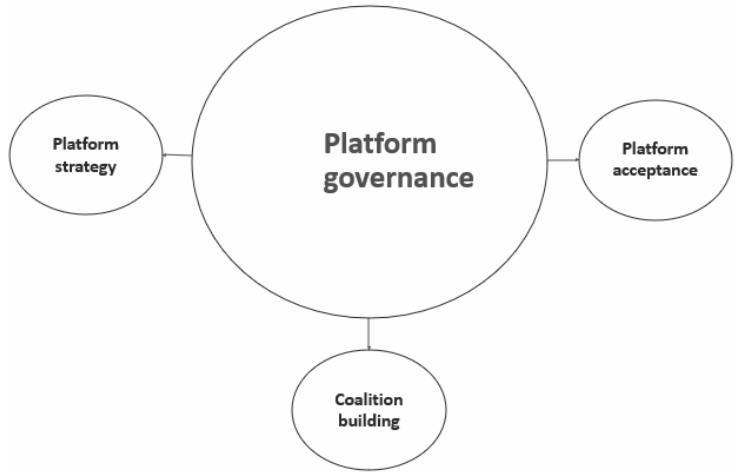
Figure 2. The components of platform governance.